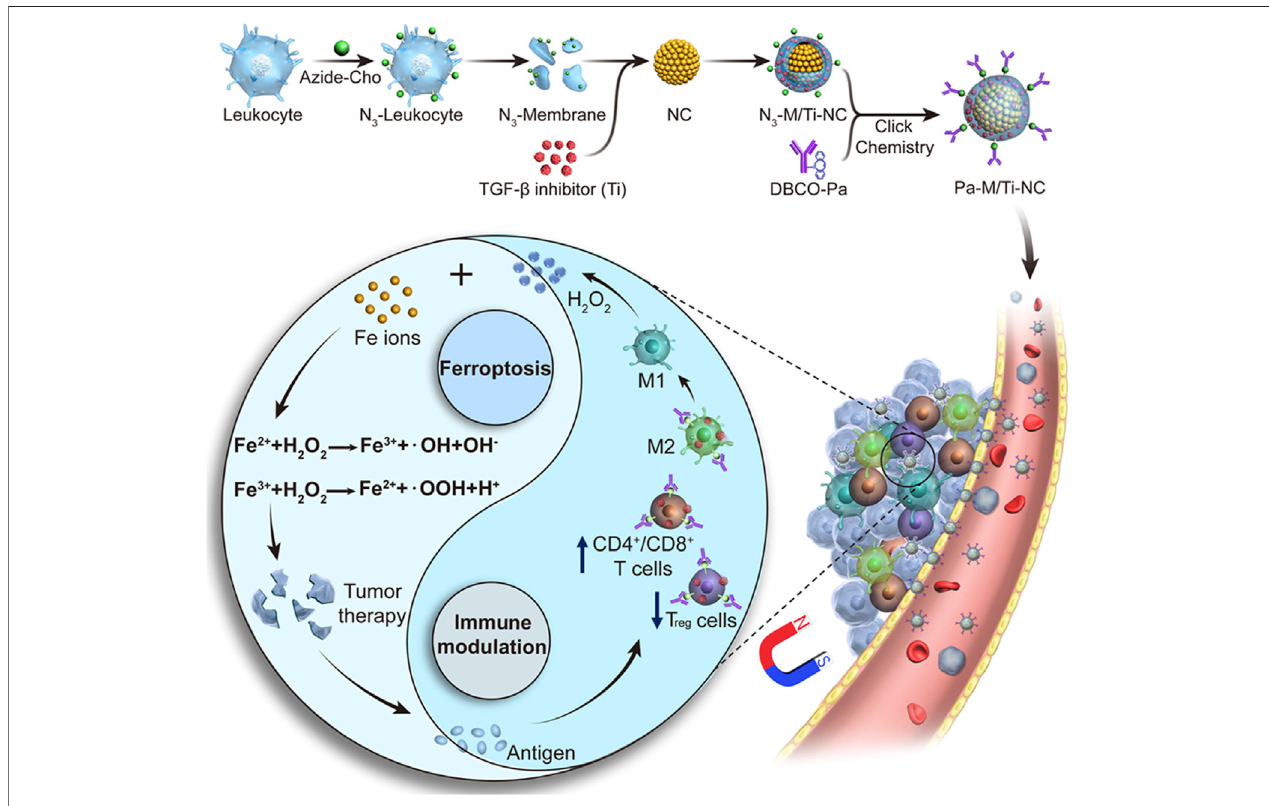
FIGURE 8 | Synthesis scheme and mechanism of the magnetosome for FBT/immunomodulation in cancer. Adapted from Zhang et al., (2019) Copyright @ 2019 (ACS).